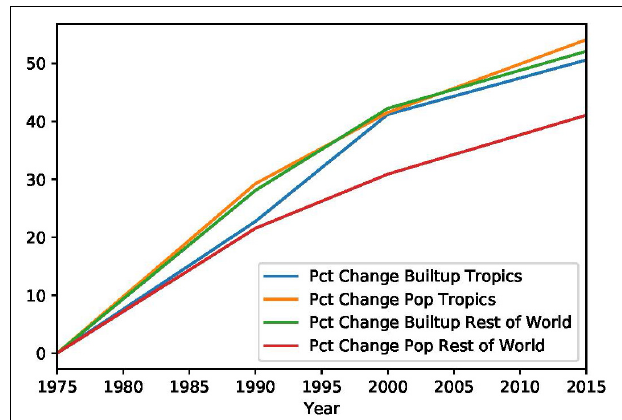
FIGURE 2 | Changes in built up area and population in the world and tropics, 1975 – 2015. Data source: